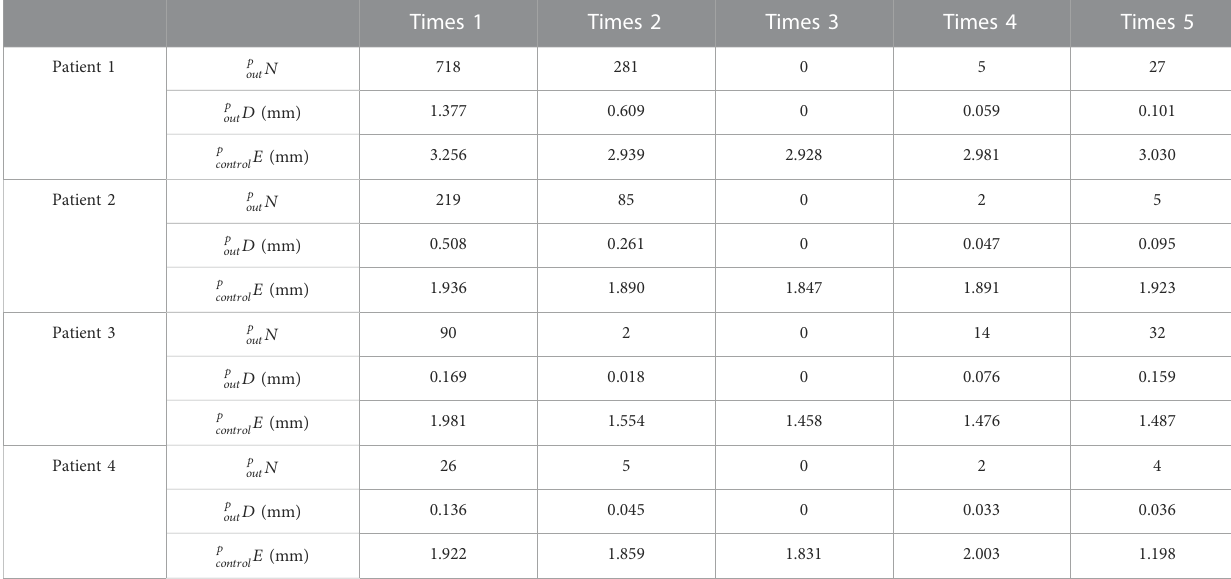
TABLE 1 Registration of different growth times of the isthmus centerlines in 4